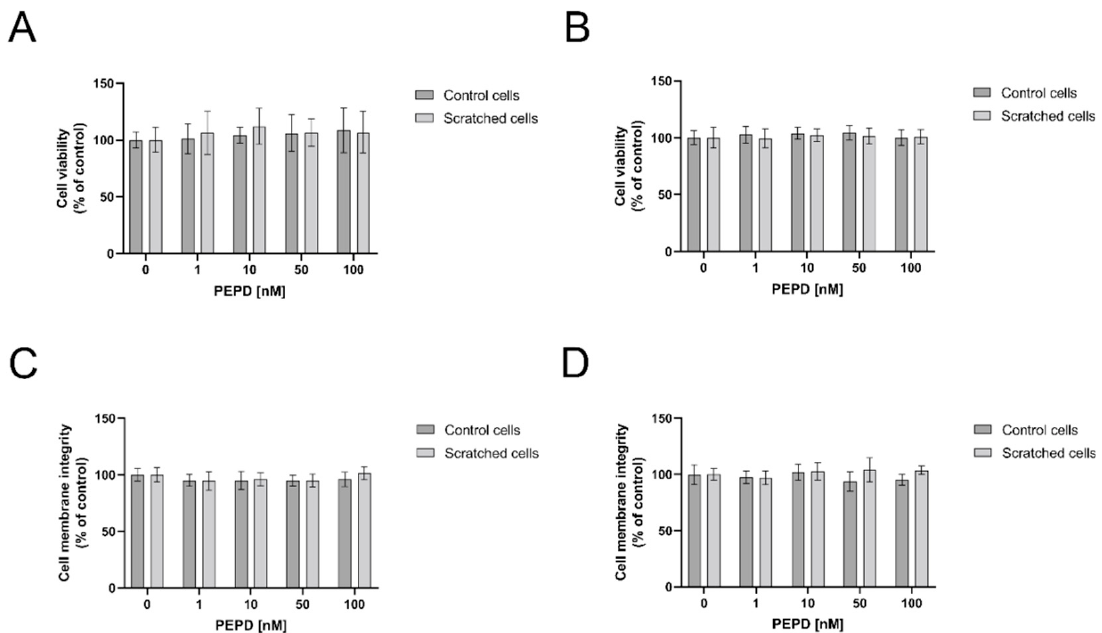
Figure 1. The effect of PEPD on fibroblasts viability and cell membrane integrity. Control cells, as well as scratched fibroblasts, were treated with PEPD (1–100 nM) for 24 h ( A , C ) and 48 h ( B , D ) followed by measurement of MTT and cell membrane integrity, respectively. Mean values ± SD of three experiments done in replicates are presented. The results are significant at a, b < 0.05 indicates a vs. control (0 nM of PEPD) of control cells, b vs. control (0 nM of PEPD) of scratched cells, respectively.